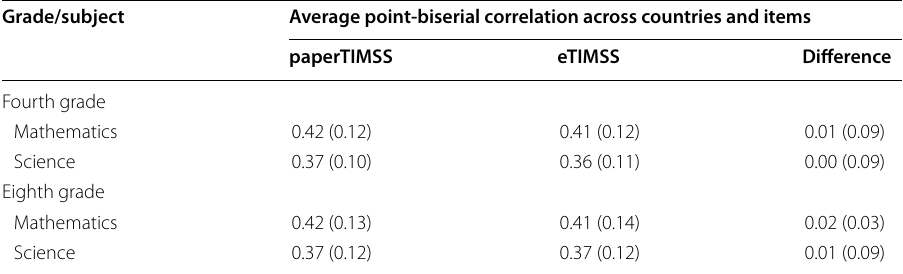
( ) Standard deviations appear in parentheses. Standard deviations of item point‑biserial correlations were computed across items in each country and then pooled across countries. Because of rounding some results may appear